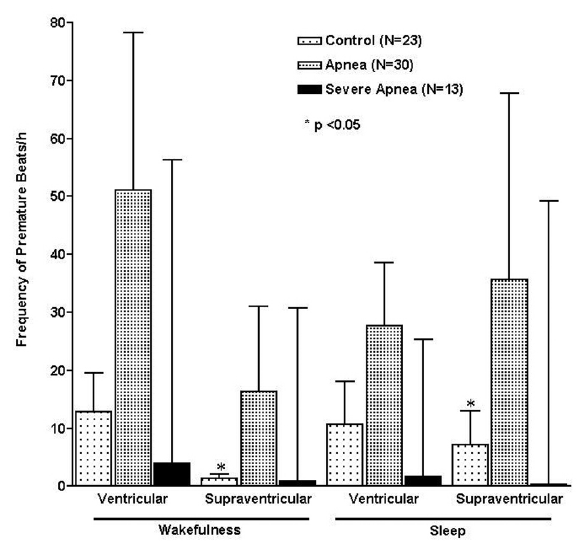
Figure 3 - Comparison of the number of ectopic ventricular and supraven- tricular beats per hour during wakefulness and sleep in the same